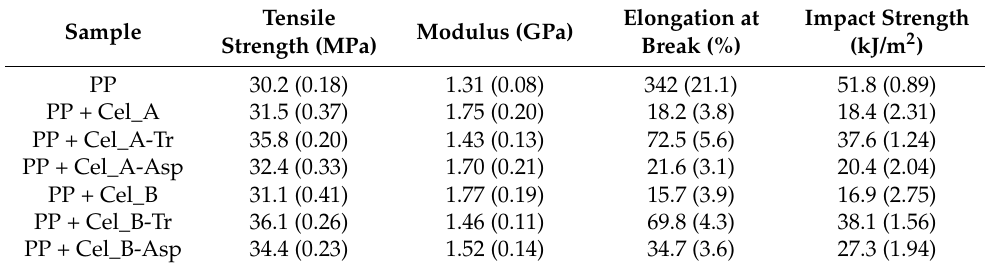
Table 7. Mechanical tests for composite materials and polypropylene